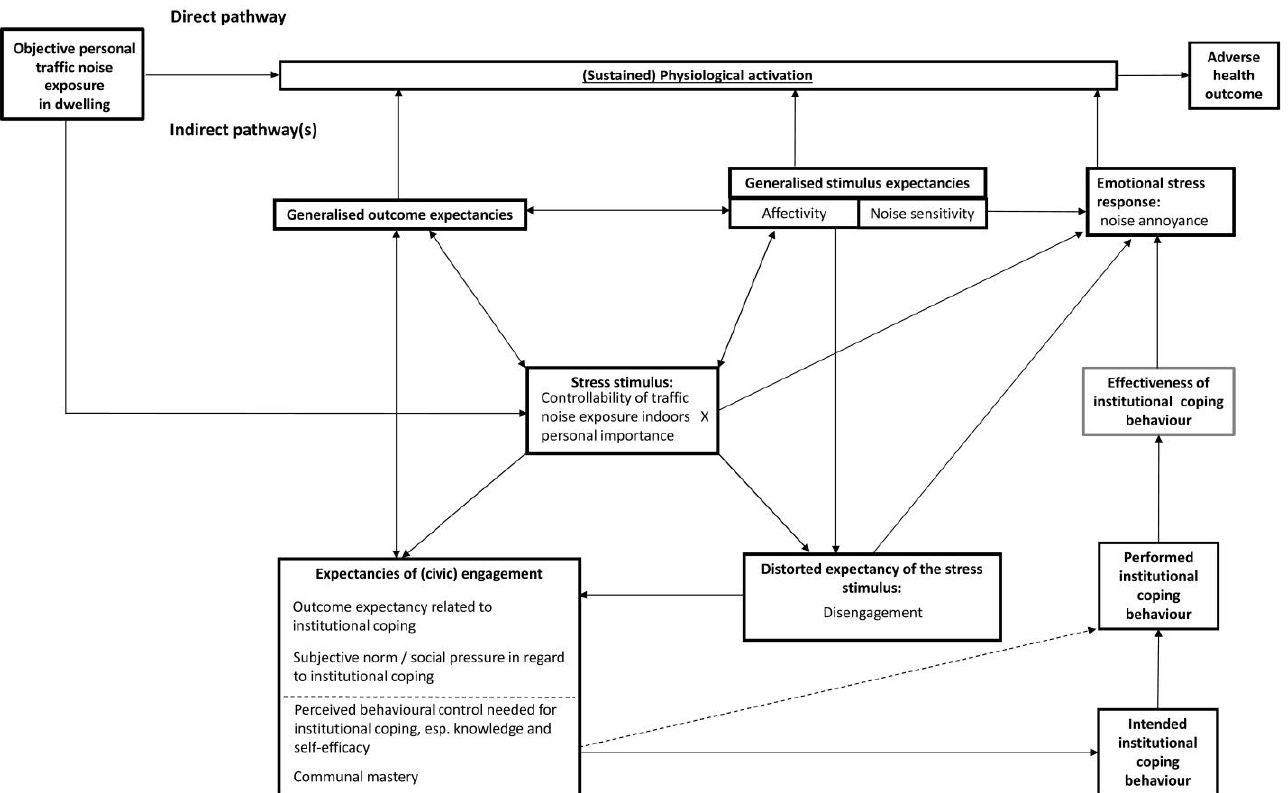
Figure 1. First step towards a refined model: reframing MOVE based on